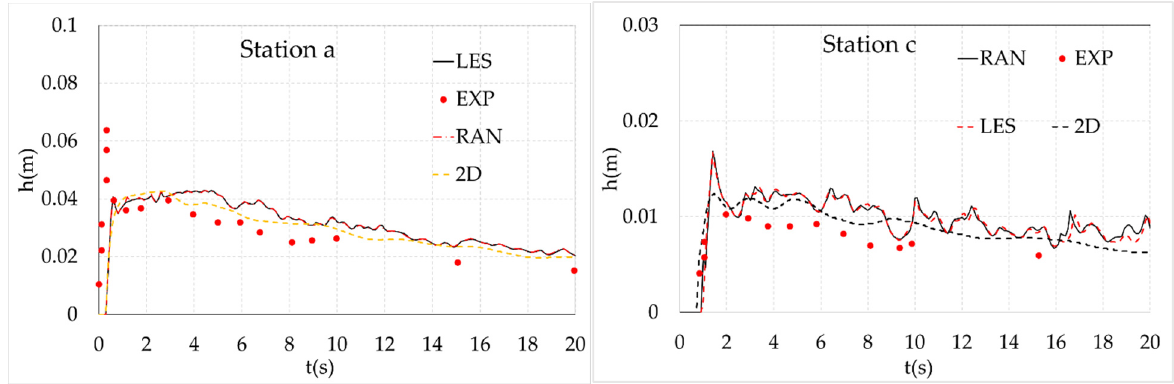
Water 2021 , 13 , x FOR PEER REVIEW